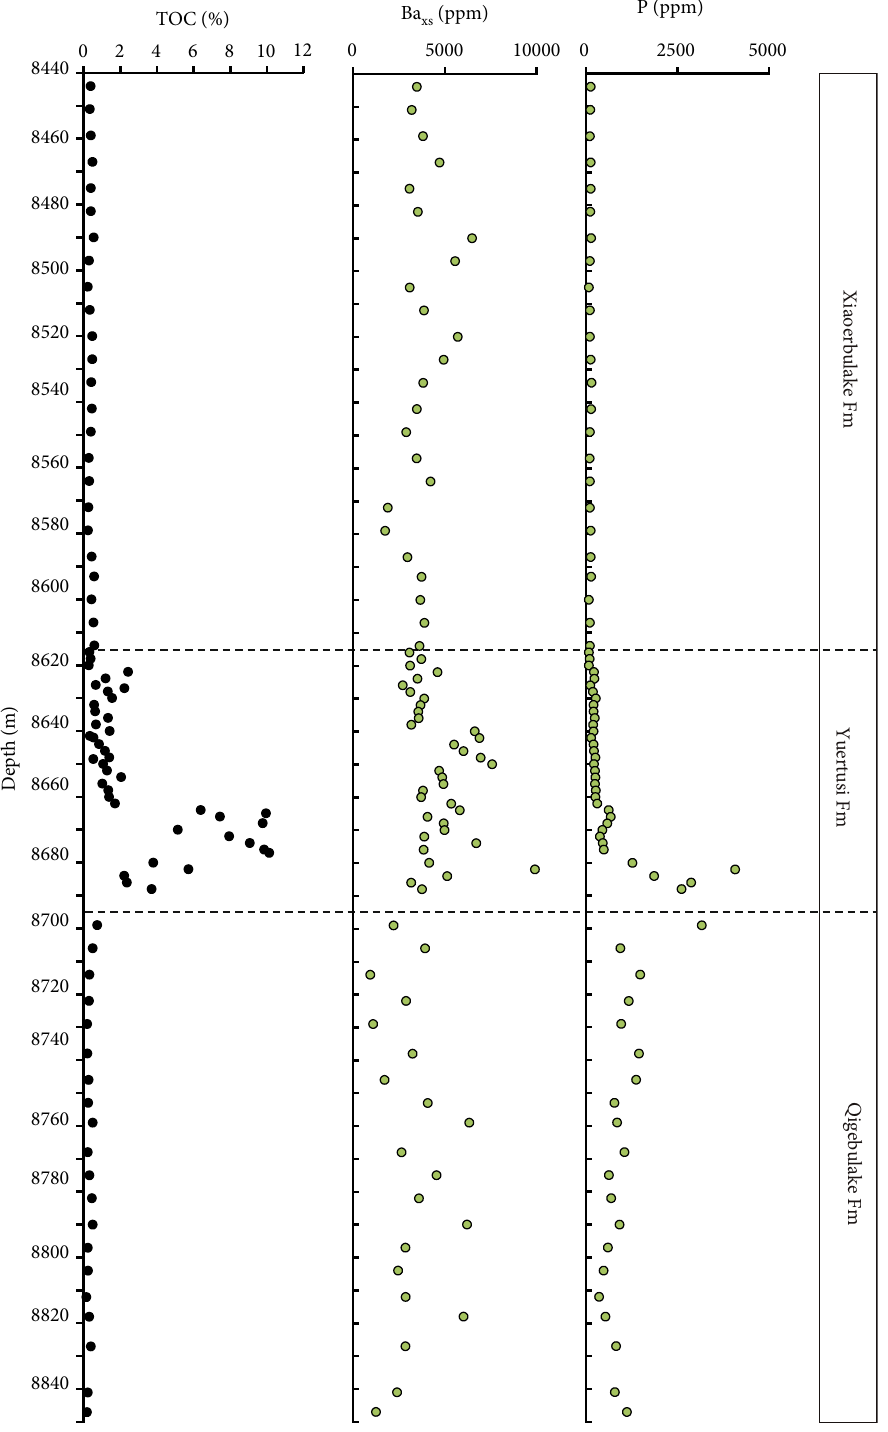
Figure 5: Pro fi les of TOC, Ba